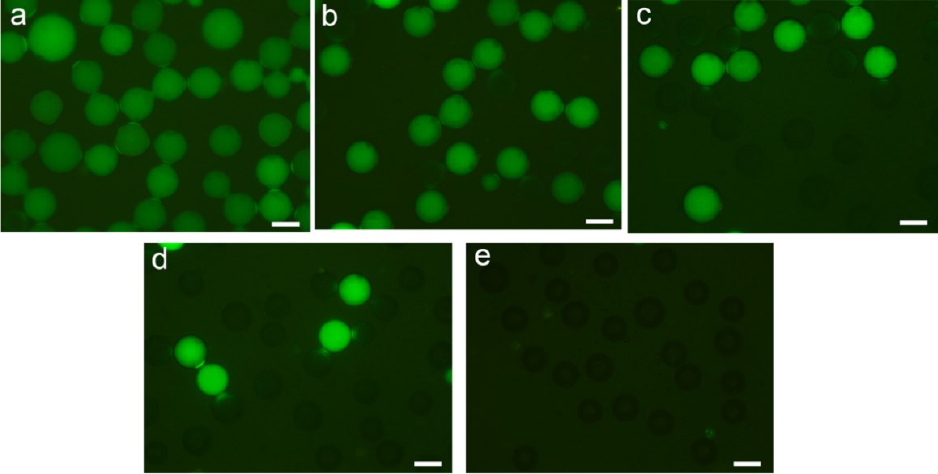
Figure 4. Droplet digital LAMP results by the proposed inkjet printer with different concentrations of HPV16 DNA. The scale bar is 50 μm. (Representative image sections cropped). ( a ) Representative fluorescent image of LAMP reaction results with 10 −2 fg/μL HPV16 DNA . ( b ) Representative fluo- rescent image of LAMP reaction results with 10 −3 fg/μL HPV16 DNA. ( c ) Representative fluorescent image of LAMP reaction results with 10 −4 fg/μL HPV16 DNA. ( d ) Representative fluorescent image of LAMP reaction results with 10 −5 fg/μL HPV16 DNA. ( e ) A representative nontemplate control (NTC) image after LAMP reaction.